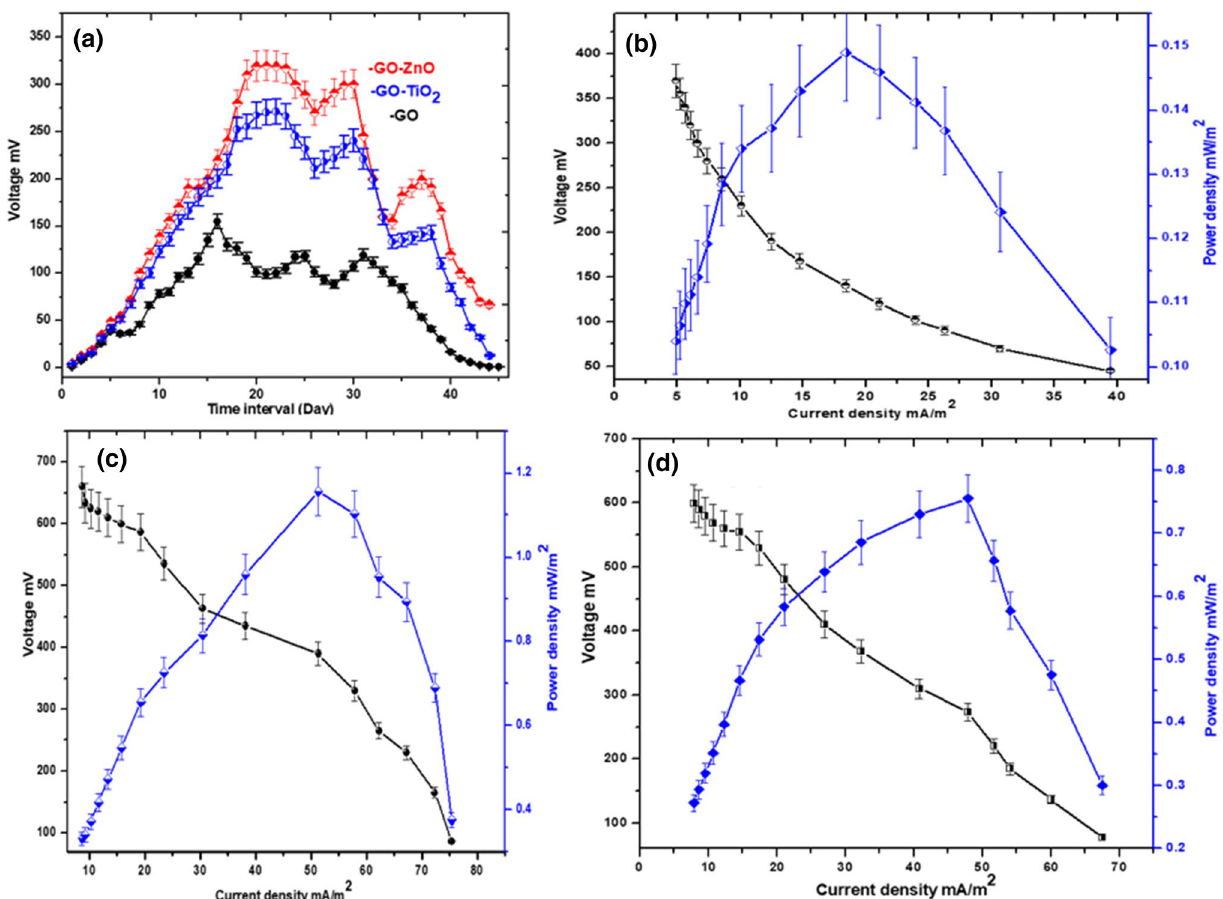
Fig. 5 a Voltage generation trend with fixed external resistance b GO polarization behaviour c GO-ZnO composite-anode and d GO-TiO posite-anode polarization behaviour with external resistance (150 Ω to 10 kΩ)